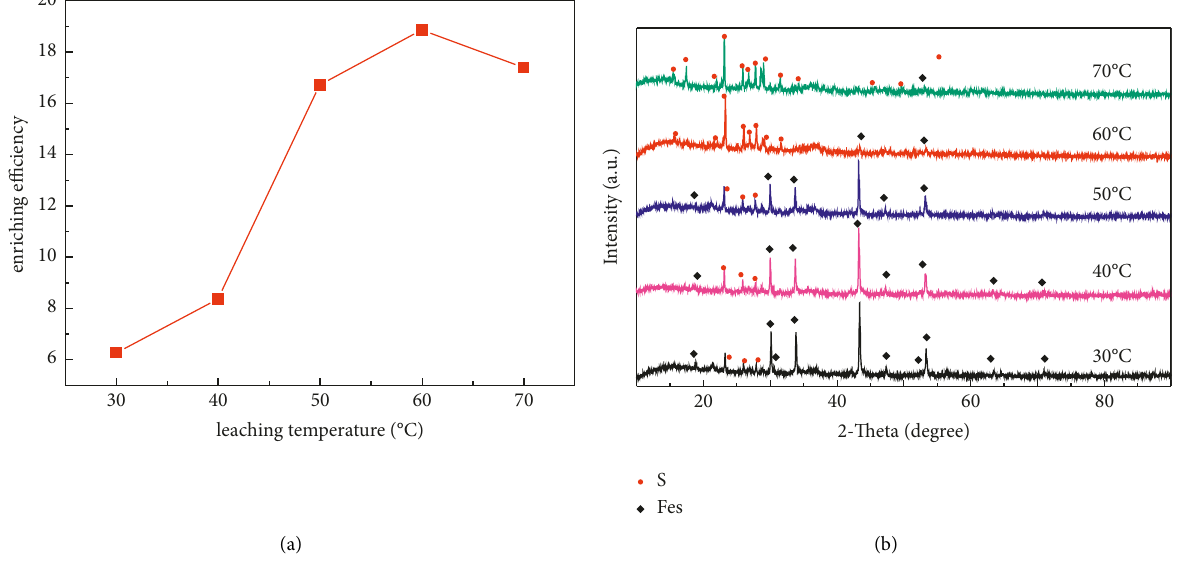
Figure 7: Effects on (a) Pt enriching efficiency and (b) XRD analysis of leaching residue with different temperatures.